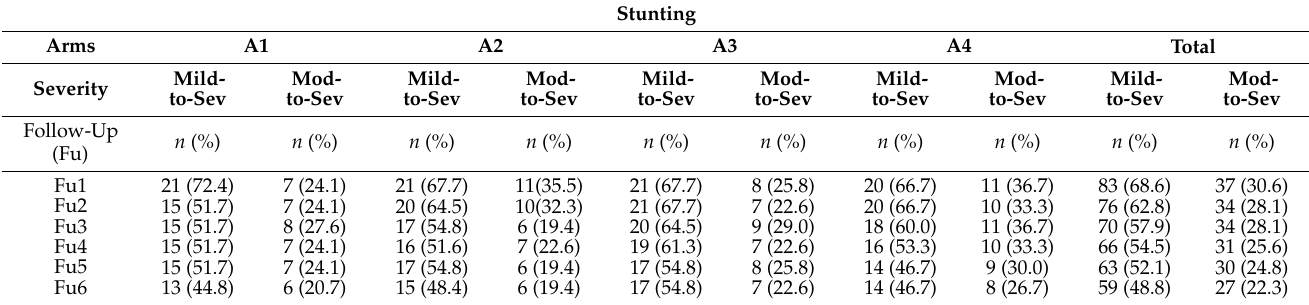
Table 1. The numbers ( n ) and the percentages (%) of children with mild-to-severe (Mild-to-Sev) and moderate-to-severe (Mod-to-Sev) stunting, by follow-up assessment.